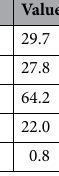
Table 6. Ophthalmic artery wall parameters used for fiber-reinforced double layer model based on internal carotid artery wall parameters according to 46 .